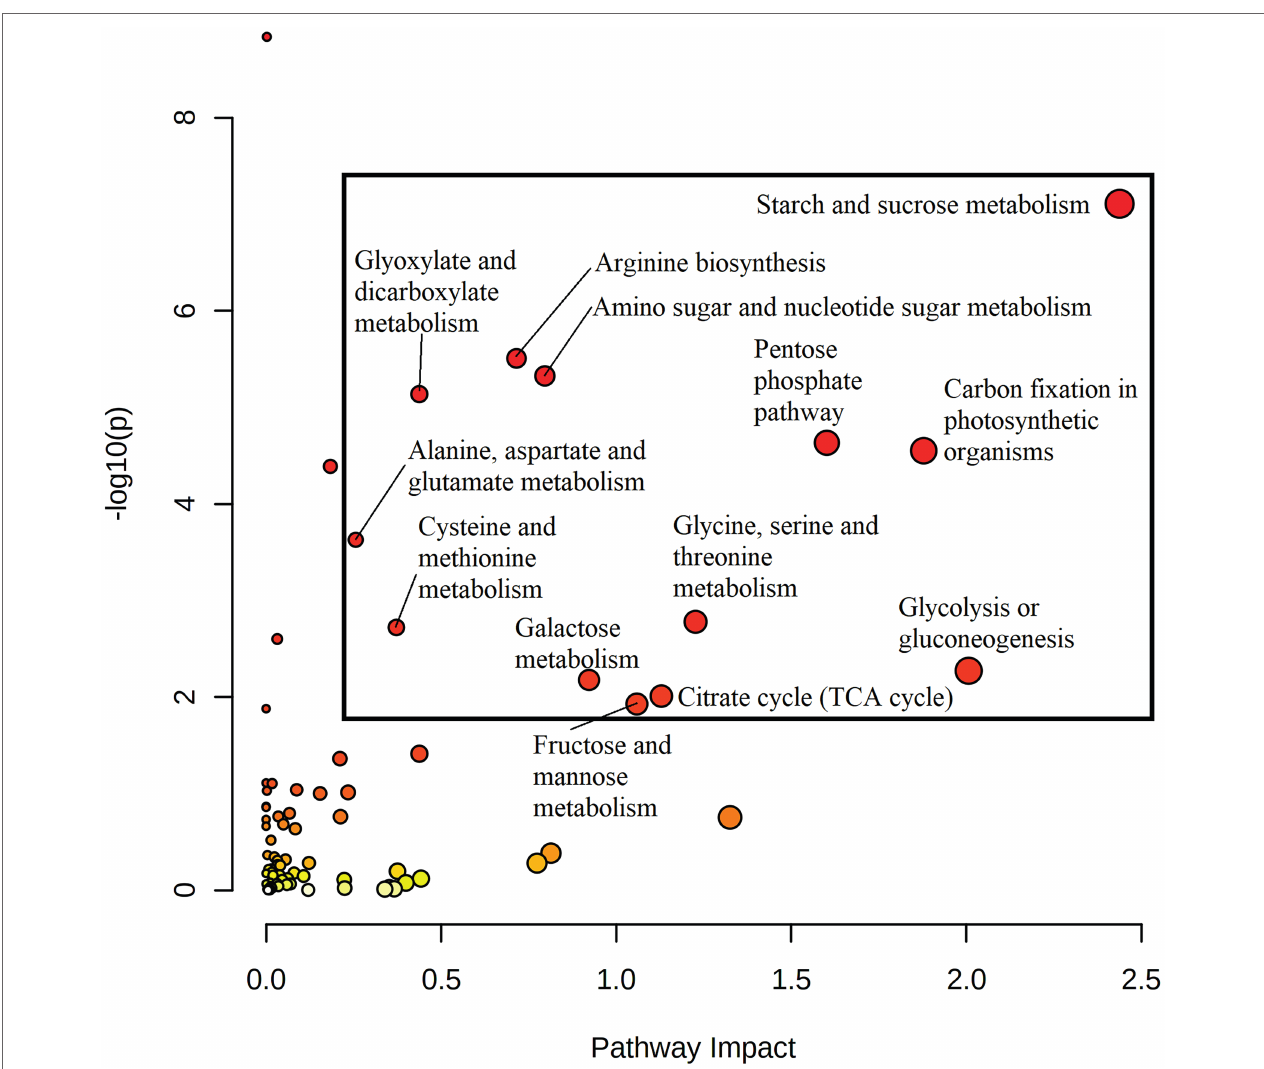
FIGURE 4 | A joint pathway analysis was performed in order to detect pathway enrichment and analyze pathway topology at 20 DAP (the maximum point of divergence in FA content for both accessions prior to the cessation of metabolic activity). Node size indicates magnitude of pathway impact, whereas node color indicates enrichment analysis significance (with red indicating higher significance). Pathways that returned with a p adj ≤ 0.05 and pathway impact value ≥ 0.2 were considered significant. All returned pathways were from the KEGG database (Kanehisa and Goto, 2000; Kanehisa, 2019; Kanehisa et al.,